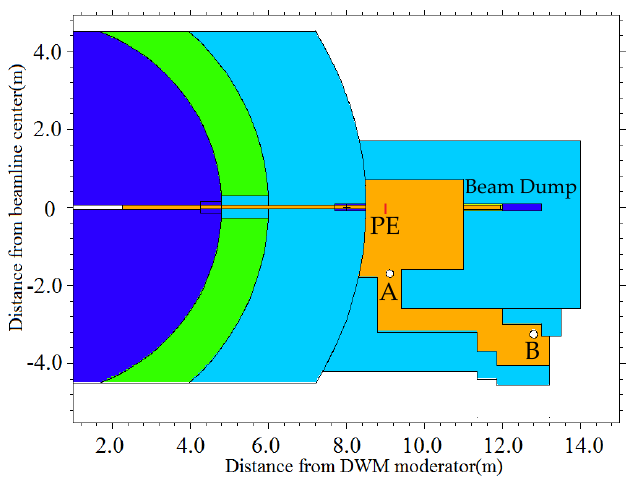
Figure 2. Geometry of BL06. A and B indicate two measurement locations. (Dark blue—carbon steel; green—heavy concrete; light blue—ordinary concrete; orange—experimental area).